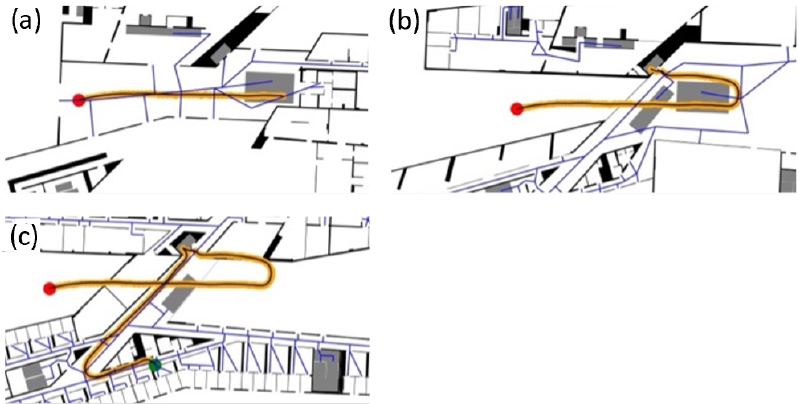
Figure 8. Ground truth points (orange) of the zerotofour path in ( a – c ); the red dot is the starting position and the green dot is the